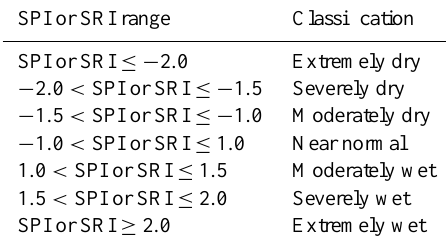
Table 2. SPI or SRI classes. SPI or SRI